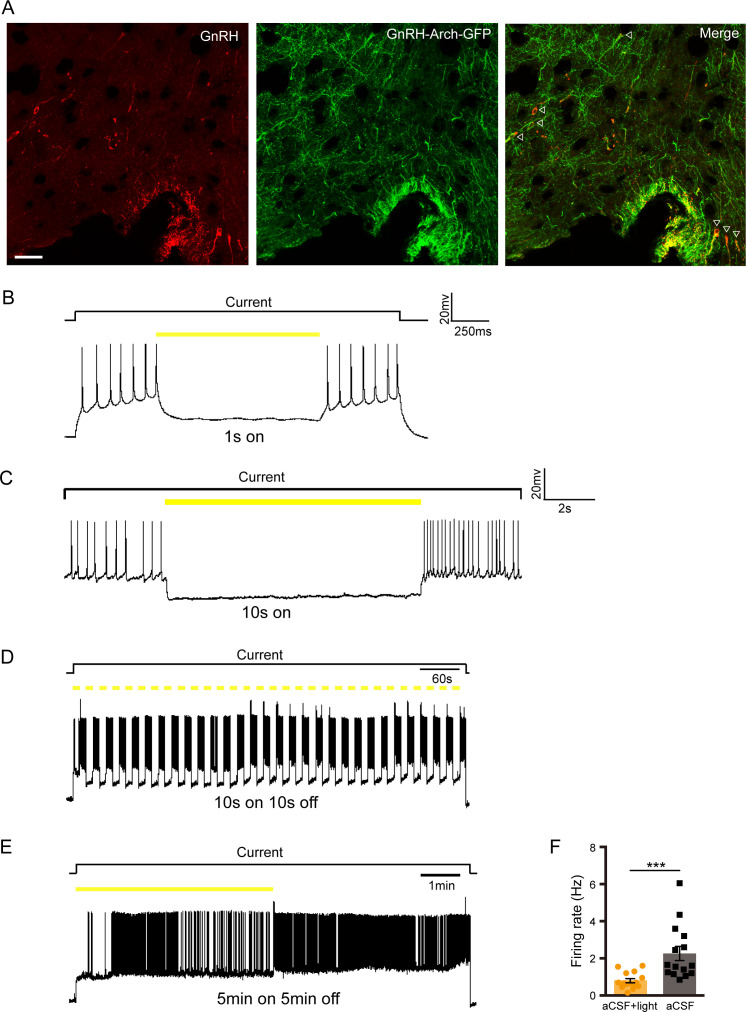
Archaerhodopsin expression in GnRH neurons and effects of yellow light on GnRH neuron firing.(A) Photomicrographs showing Archaerhodopsin (GFP reporter), GnRH (red), and overlay in the GnRH-cre+/-;Rosa-CAG-Arch3-GFP+/+ mice. Scale bar, 50 µm. Whole cell current clamp recordings of Archaerhodopsin-expressing rPOA GnRH neurons showing their response to 1 s (B) and 10 s (C) yellow-light. (D) Example traces illustrating the response of an rPOA GnRH neuron to a 10-min yellow light stimulation train at 10 s on 10 s off. (E) Example traces illustrating the response of an rPOA GnRH neuron to a 10 min yellow light stimulation at 5 min on 5 min off. (F) The mean firing rate of an rPOA GnRH neuron with or without 5 min continuous yellow light. **p<0.001, repeated measures ANOVA.